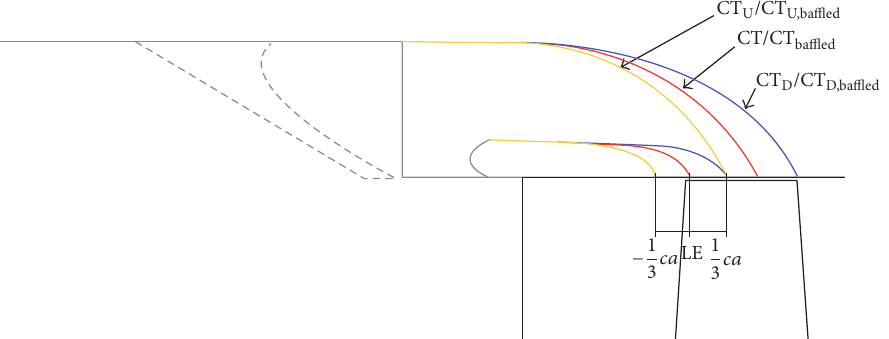
Figure 8: Different slot positions.